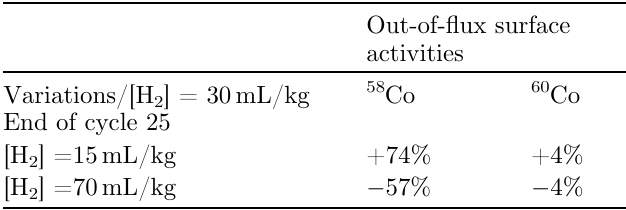
Table 3. OSCAR V1.3 calculation (cid:2) Relative variations of the deposited activities on the out of core surfaces compared to a DH value of 30